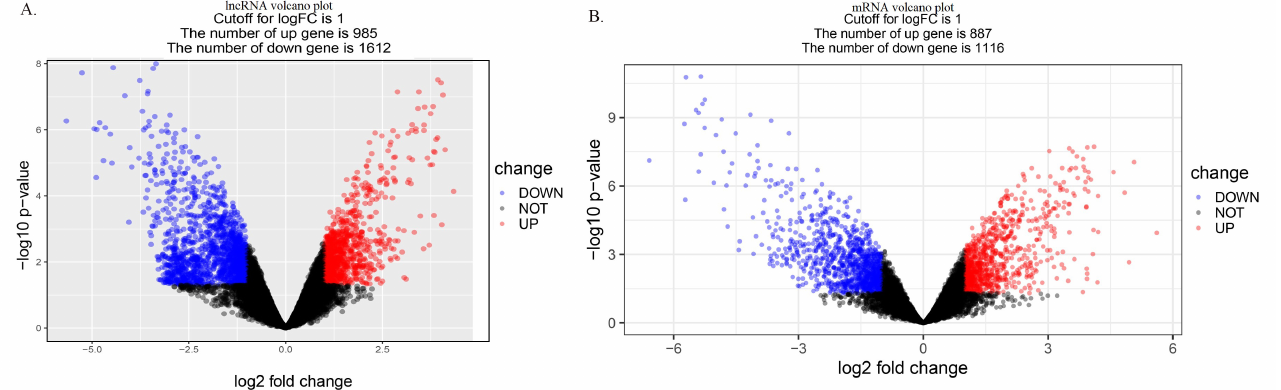
Figure 2. Volcano plots illustrating data distributions in ( A ) lncRNA and ( B ) mRNA profiles. Red denotes high relative expression and blue denotes low relative expression.